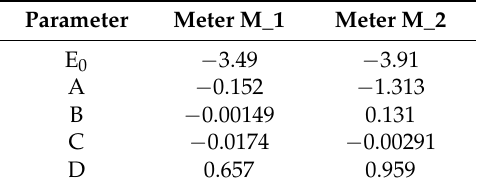
Table 7. The regression parameters values of the proposed equation for the two meter types under study.